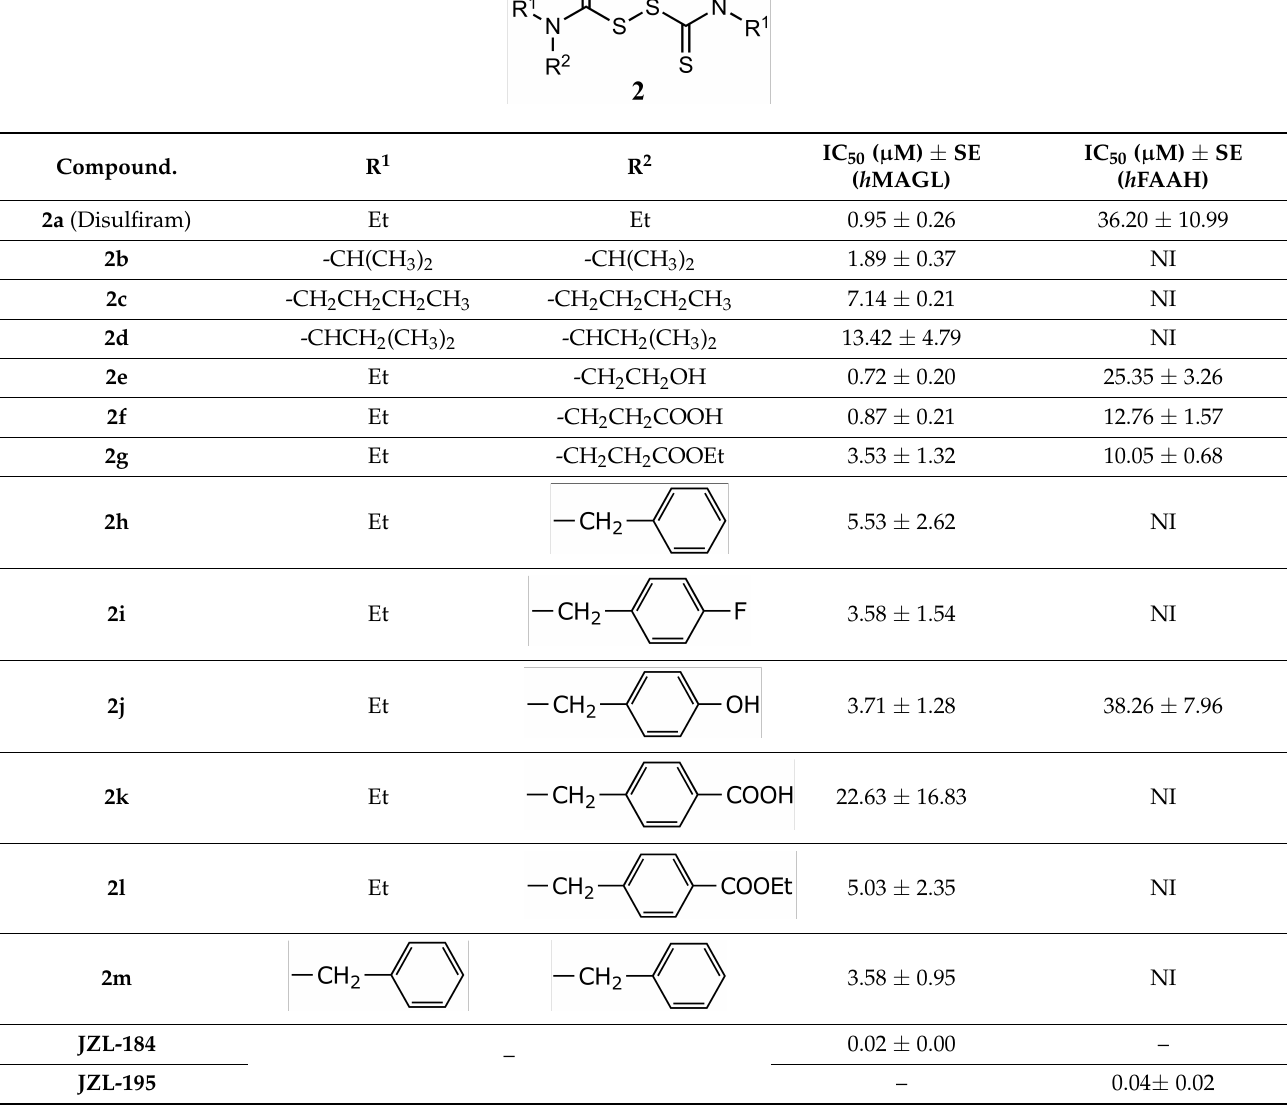
Table 1. Inhibition of h MGAL and h FAAH by disulfiram and its analogues 2b – m . JZL-184 and JZL-195 were included in the test as known inhibitors. The data are presented as the average of at least two different experiments ± the standard error.